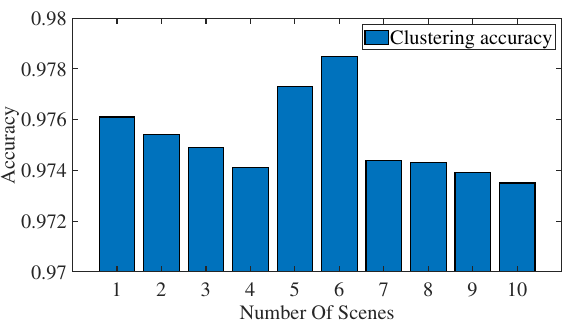
Figure 20. Accuracy of clustering using SDPFC algorithm in 1000